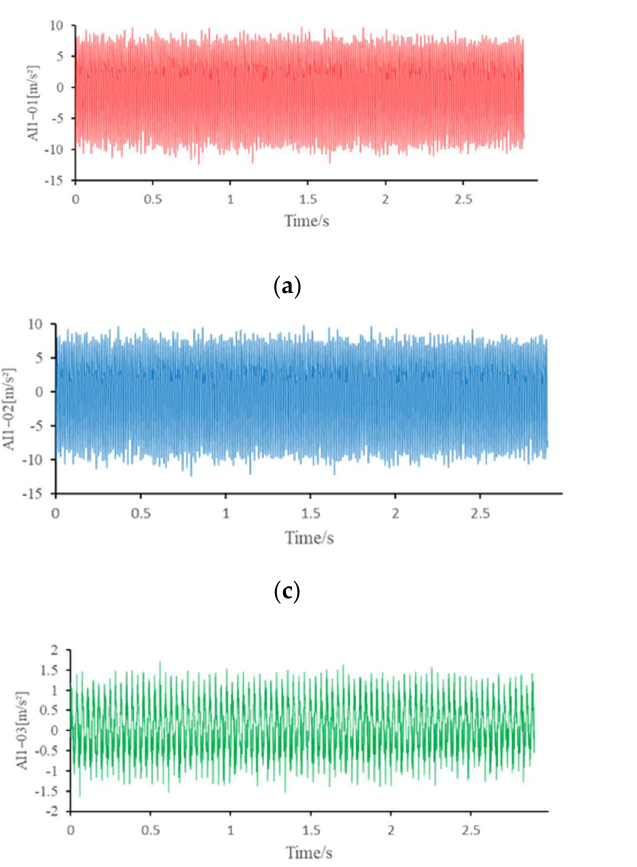
Due to many measurement points, the time domain and frequency domain diagram obtained from the analysis of measurement point 1 is used as an example (shown in Figure 15).